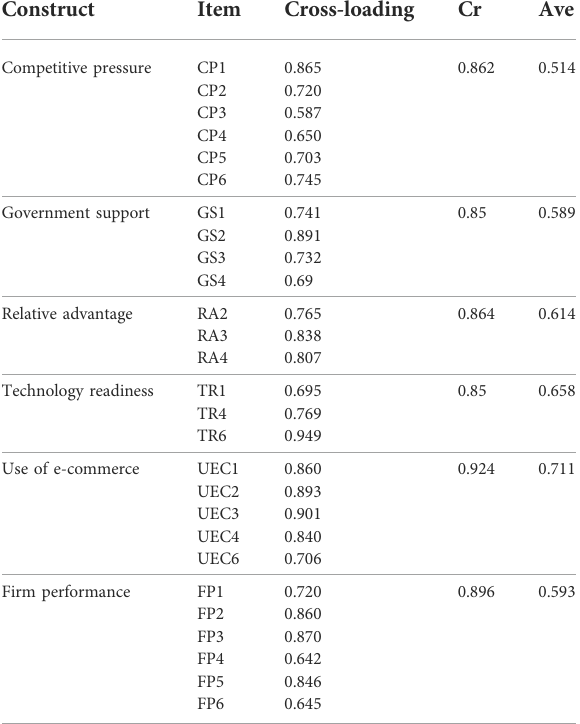
TABLE 4 Assessment result of a measurement model.